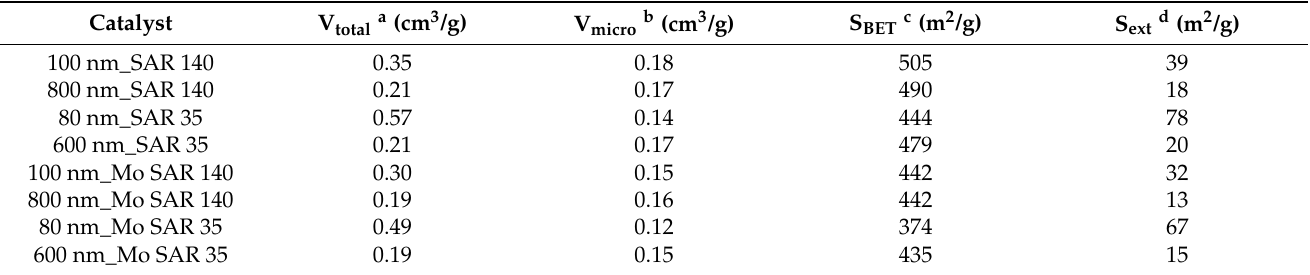
Table 1. Texture properties of core–shell zeolite samples.